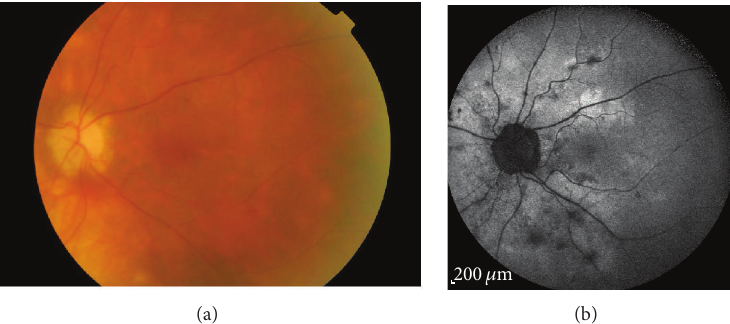
Figure 3: Areas of hypoautofluorescence in birdshot chorioretinopathy. (a) corresponds to the typical lesions in most parts and (b) shows more widespread lesions than the ophthalmologically visible area of